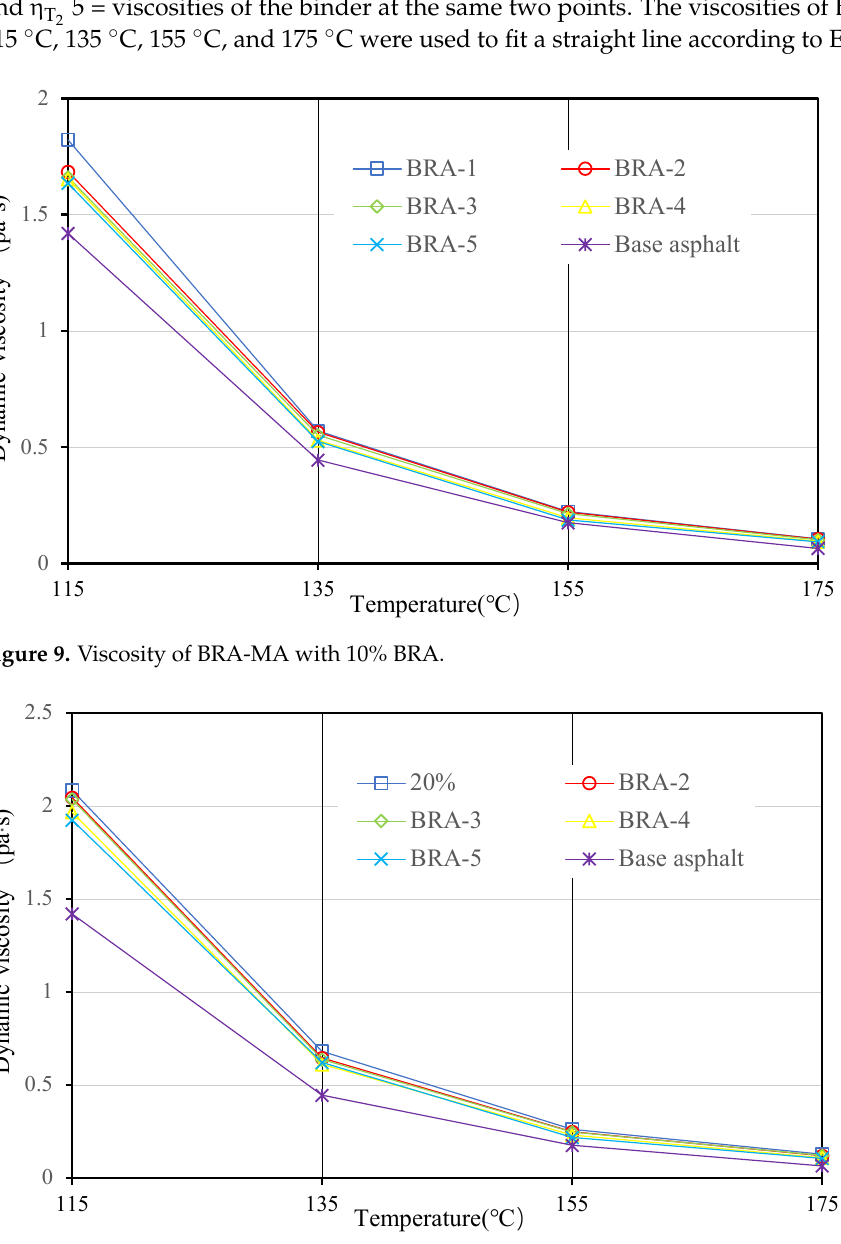
Figure 10. Viscosity of BRA-MA with 20% BRA.